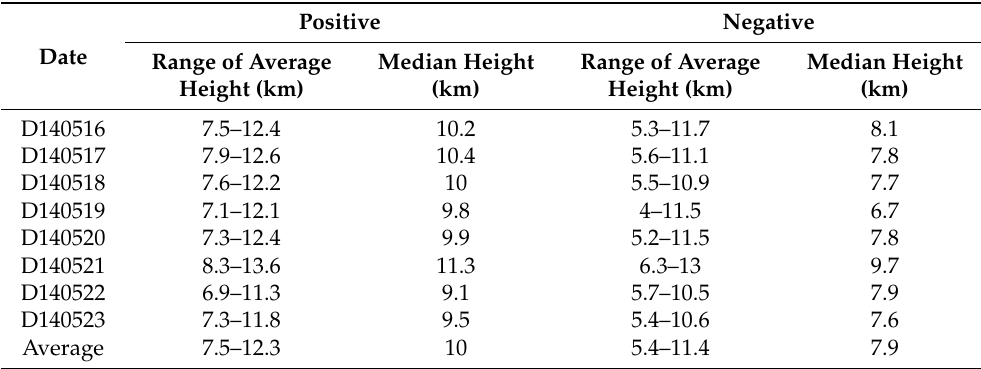
IC events is processed by the denary logarithm (the right y -axis). Lines marked with circles belong to the positive events, and lines marked with diamonds represent the negative events. The solid red lines show the number of IC events versus height during the whole 10 h, with the dark blue chain-dotted lines in the first 5 h (from 11:00 to 16:00) and the light blue chain-dotted lines in the second 5 h (from 16:00 to 21:00). The dot lines represent the distribution of IC events in 60 min from 11:00 to 21:00. Table 3. The average height distributions of IC events on 8 consecutive thunderstorm days with the proportion range from 20% to 80%.